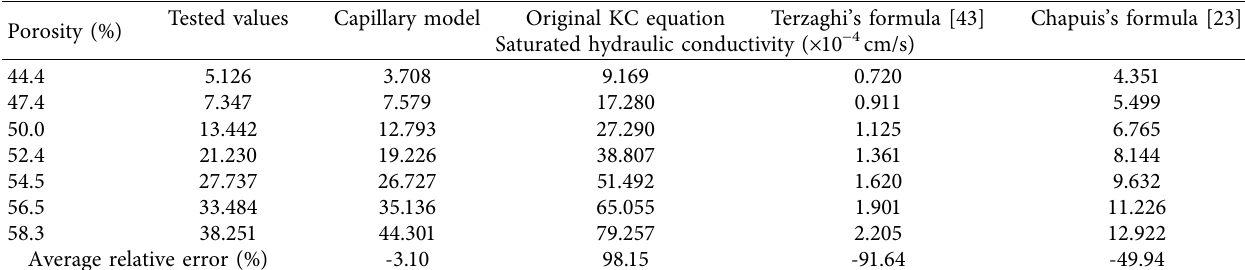
Table 3: Calculation results of different